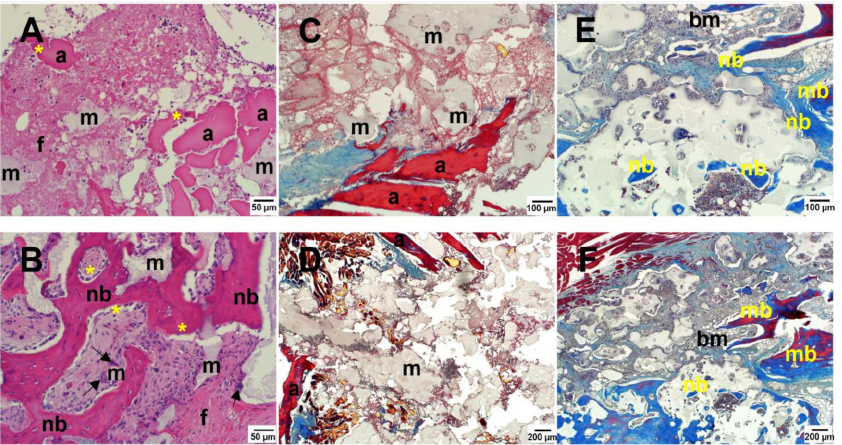
Figure 5. H&E staining of the transverse processes at ( A ) 3 days and ( B ) 12 weeks shows that granules released by BCP-EP are in direct contact with cells, including multinucleated cells (black arrow) and extracellular matrix. Osteoblasts (yellow asterisks) were observed to deposit new bone matrix. Tetrachrome staining at ( C , D ) 3 days and ( E , F ) 12 weeks showed the progressive formation and mat- uration of novel bone and bone marrow spaces. No adverse reaction was noted. Legend: m: calcium phosphate material; a: autograft particles; b: bone; nb: new bone; mb: mature bone; f: fibrous tissue; bm: bone